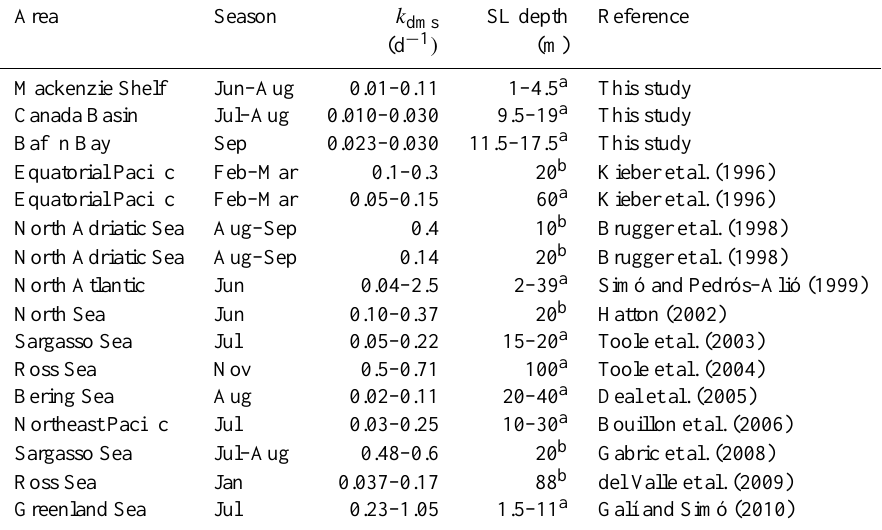
Table 4. Photochemical DMS turnover rate constants in the surface layer (SL) from this study and the literature. Mackenzie Shelf includes MER-E and MER-W as defined in Table